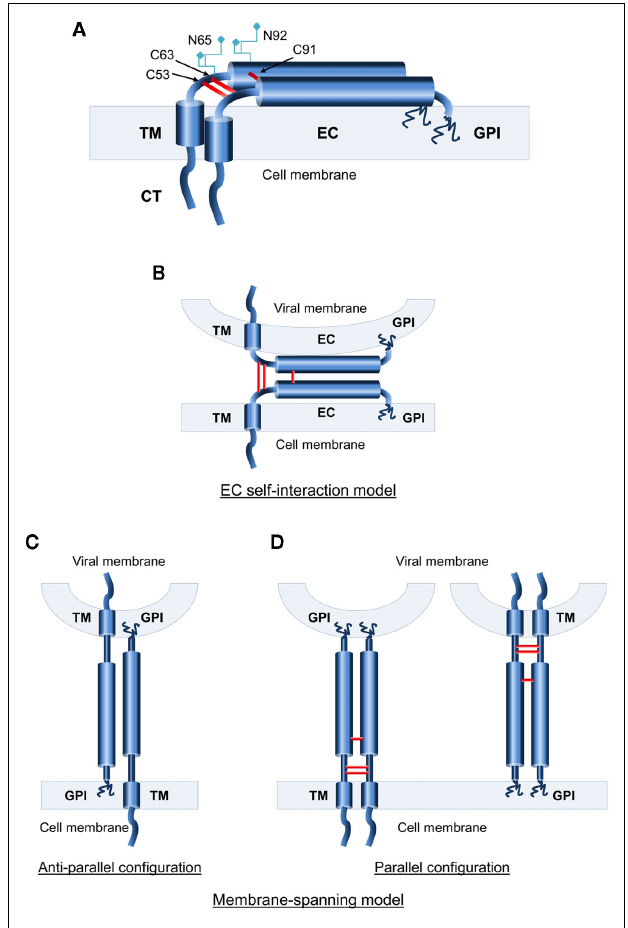
FIGURE 1 |Topological characteristics of human BST-2. (A) Schematic representation of the domain structure of BST-2, a type II transmembrane (TM) protein. BST-2 features a short cytoplasmic N-terminus followed by an α -helical single-passTM domain and an extended coiled-coil extracellular domain that is linked back to the plasma membrane by a C-terminal GPI anchor. N -glycosylation sites and cysteine residues for disulfide-bond formation in the extracellular domain (EC) are noted. (B–D) Topological models of BST-2’s functional state. (B) The EC self-interaction model, in which individual BST-2 monomers are anchored at both ends to the same membrane, with interaction between the ECs of cell-bound and virion-bound monomers. (C) Membrane-spanning anti-parallel model. Monomers are anchored in both membranes with opposing orientations. (D) Membrane-spanning parallel model. Monomers are anchored in both membranes with the same